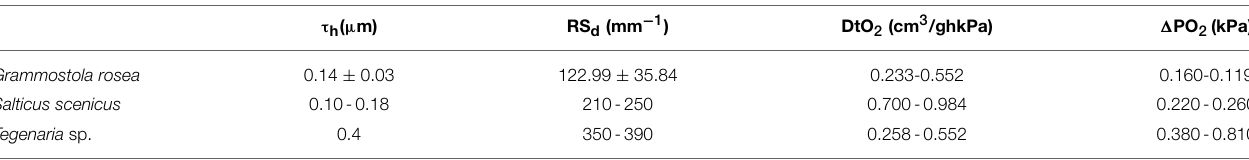
TABLE 2 | Respiratory refinements of the spiders Grammostola rosea (Theraphosidae) (Canals et al., 2008), Salticus scenicus (Salticidae) (Strazny and Perry, 1984) and Tegenaria sp. (Agelenidae) (Schmitz and Perry, 2001).